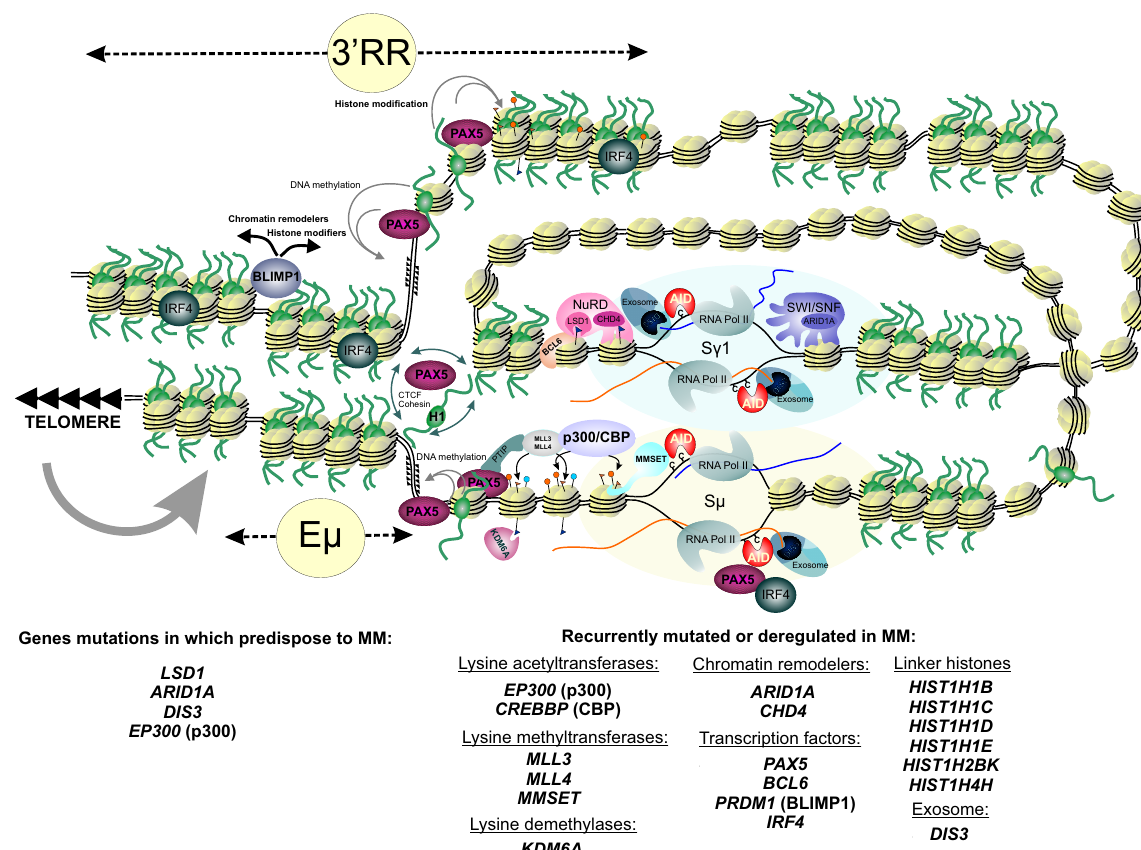
Figure 6. Factors affecting genomic stability and CSR at the IGH locus are implicated in MM development. A hypothetical scheme (based on studies in murine and human models) that includes factors essential for the IGH locus reorganization and CSR. Many of these factors are encoded by genes mutations in which predispose to MM development and genes that are recurrently mutated in MM. Development of MM may be linked to genomic instability at the IGH locus: IGH translocations are observed as early as MGUS, are frequent, and predispose to disease development since, in most cases, they fuse various oncogenes to powerful enhancers at the IGH locus. Since IGH translocations may be linked to aberrant CSR, this is evidence that MM initiation can be simply a result of aberrant CSR. CSR depends on the function of several genetic elements at the IGH locus, such as 3’RR, E µ , and S-regions. It also depends on a number of factors that aid chromatin changes and transcription through S-regions, RNA maturation and processing, and AID recruitment. Transcription factors PAX5 and BCL6 play an essential role in the IGH locus contraction and remodeling. PAX5 is a master regulator that binds to the DNA, and recruits PTIP and MLL3/MLL4 methyltransferase complex to specific regions at the IGH locus, thus promoting chromatin changes and transcription initiation at S-regions [602,603]. PAX5, together with Linker histone H1 (green spheres with tails), influences DNA methylation and histone modifications at the IGH locus [604]. BCL6 binds the promoter region of γ 1 GLT and may act by repressing the transcription at S-regions [316]. BLIMP1 and IRF4 bind to 3 (cid:48) RR and regulate transcription at IGH locus; BLIMP1 also represses transcription of AICDA and BCL6 , whereas IRF4 activates AICDA expression [200,217,605]. AID co-localizes with several transcription factors, including PAX5 and IRF4, at the IGH locus, which might play a role in AID targeting to specific locations [606,607]. Chromatin-remodeling factors ARID1A and CHD4 facilitate nucleosome reorganization required for transcription through S-regions. ARID1A is a component of the SWI/SNF complex known to be involved in antisense transcription at the IGH locus [608,609]. CHD4 is a component of the NuRD complex, which binds to H3K9me3, an epigenetic mark present at the IGH locus during CSR. CHD4 is required for CSR and coimmunoprecipitates with AID in B-cells, and this interaction was proposed to aid AID to target S-regions [610]. LSD1 is a lysine-specific demethylase that associates with the NuRD complex and also interacts with BCL6 [315]. p300